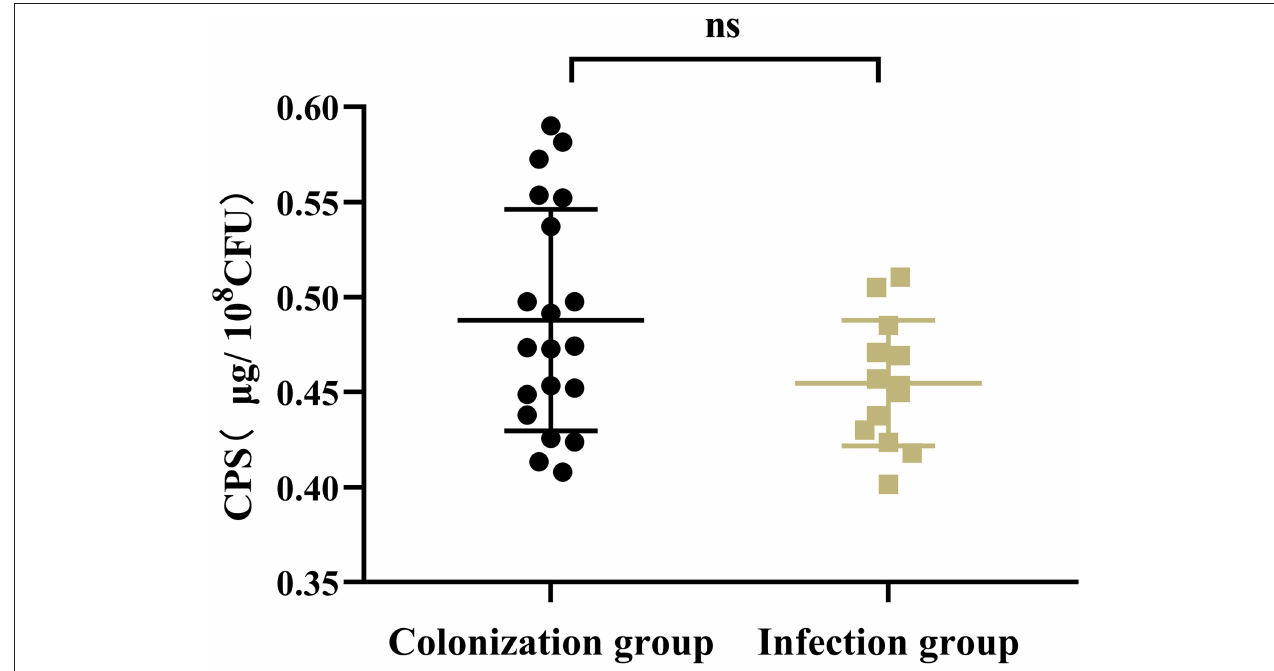
FIGURE 2 | Capsular polysaccharide content of intestinal CRKP strains. ns, no significant difference.